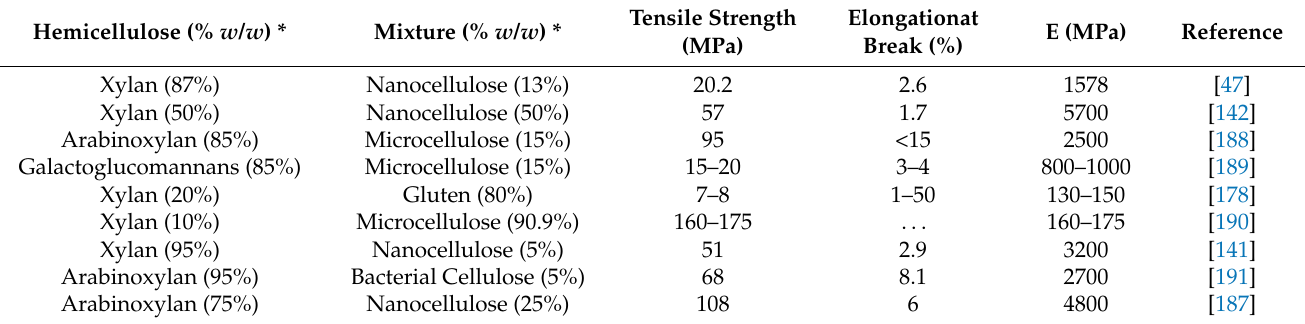
Table 2. Properties of hemicellulose-based